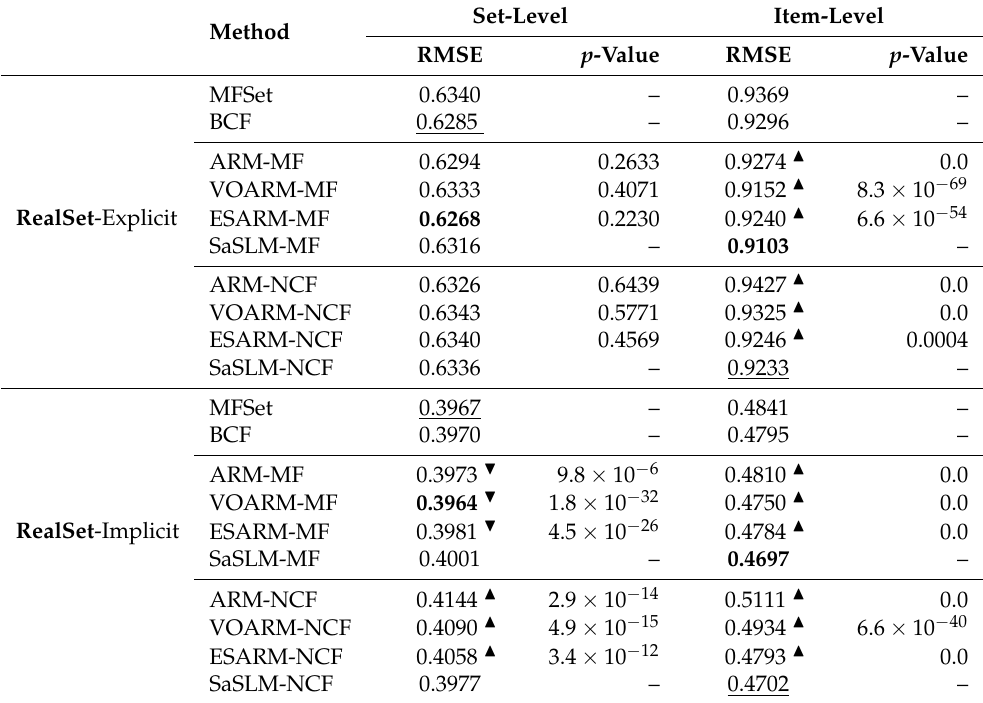
Table 4. Performance of set-rating prediction with fixed-size